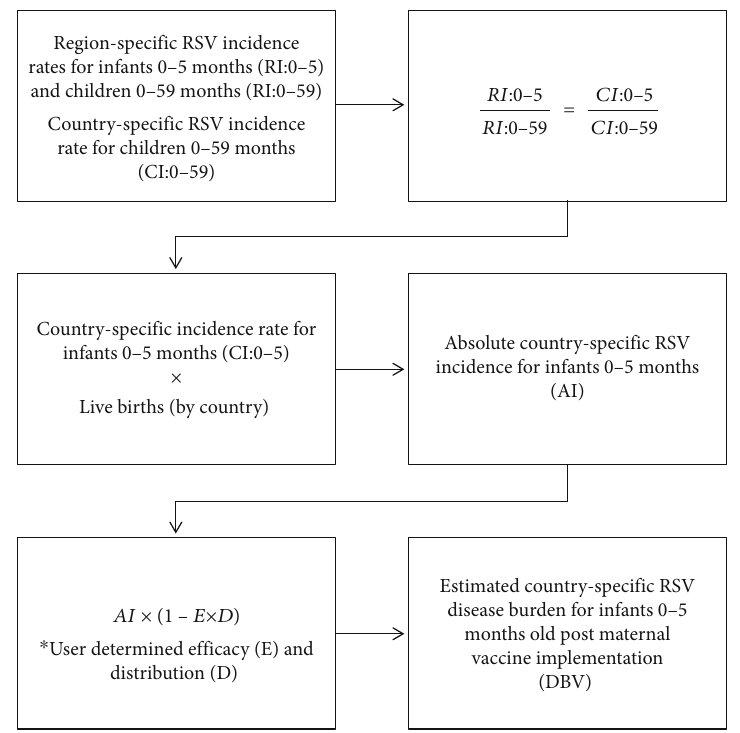
Figure 2: Flowchart of calculation of country-speci fi c infant (0-5 months) RSV